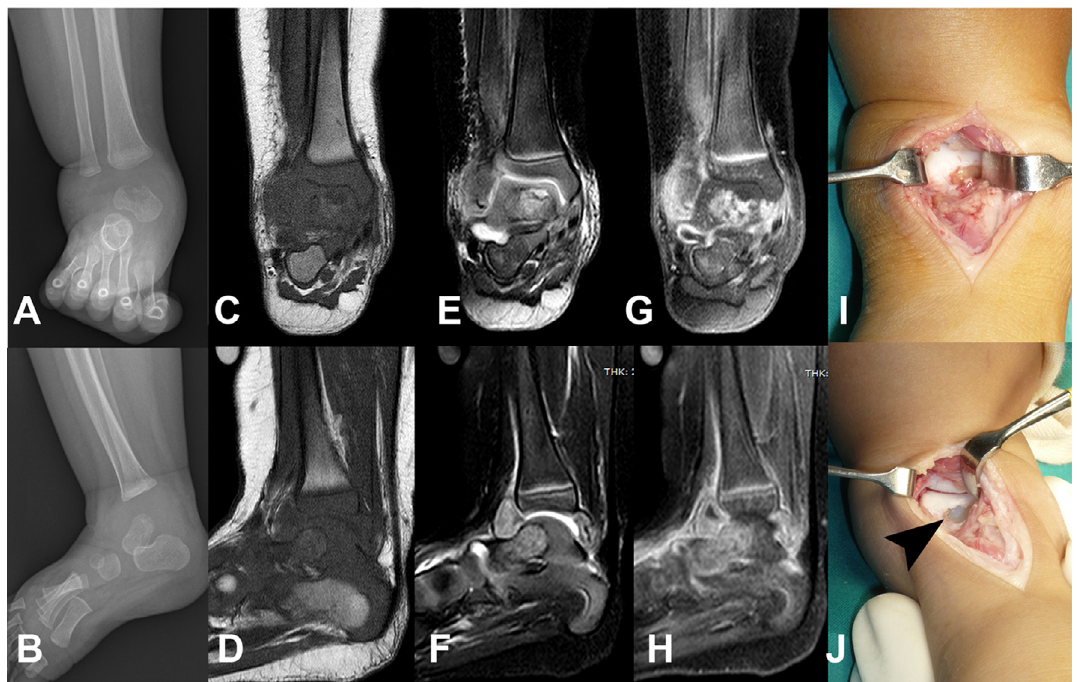
Figure 1. Anteroposterior (A) and lateral (B) radiographs of the right ankle of patient 1 are shown along with magnetic resonance imaging images in T1 weighted (C, D), T2 weighted (E, F), and gadolinium-enhanced (G, H). Intraoperative finding before (I) and after (J) debridement is demonstrated. The arrowhead represents an osteolytic lesion at the